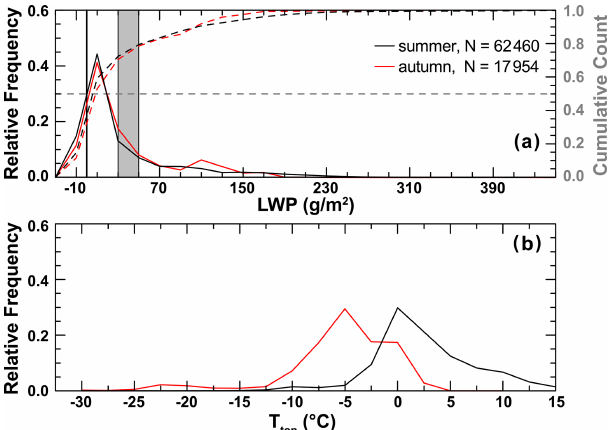
Figure 7. (a) Histogram (solid lines) and cumulative count (dashed lines) of the occurrence frequency of liquid water path and (b) his- togram of the cloud-top temperature for liquid clouds observed dur- ing summer (black) and autumn (red). Values represent individual cloud layers on a profile basis. The grey dashed line in (a) marks 50% in the cumulative counts. The vertical line in (a) marks 0gm − 2 LWP while the grey area indicates the infrared black body limit between 30 and 50gm − 2 LWP.